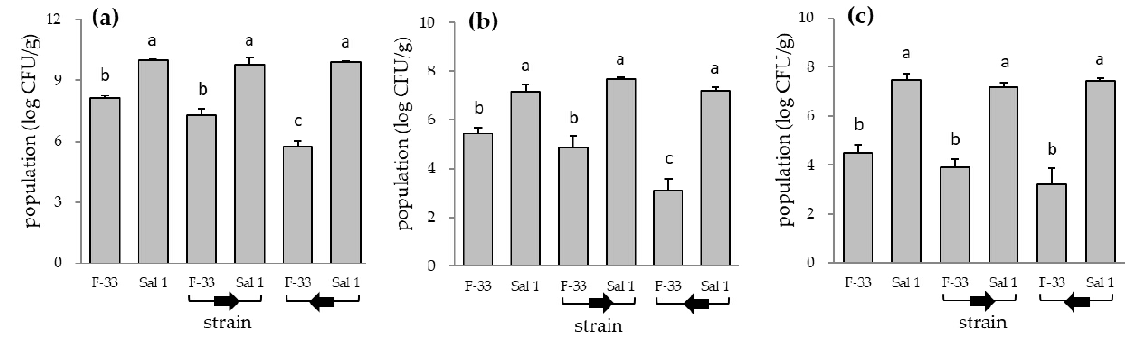
Figure 6. The effect of the time interval of inoculation of Bacillus sp. F-33 and Klebsiella sp. Sal 1 on colonization in the rhizosphere ( a ), root ( b ), and shoot ( c ) of the tomato plant. The tomato plant was cultivated using sterilized vermiculite, and colonization was examined at 14 days after seed inoculation. In the time interval of inoculation, F-33 + Sal 1 and Sal 1 + F-33, the second inoculation was conducted 7 days after the first inoculation and analyzed 7 days after the second inoculation. The bracket on the x-axis indicates each population in the time interval of inoculation, and the arrows on the bracket indicate the order of inoculation. No bracket indicates a single inoculation. No colony appeared in the control samples. The bars represent the standard deviation (n = 3), and different letters indicate significant differences at p < 0.05 by Tukey’s